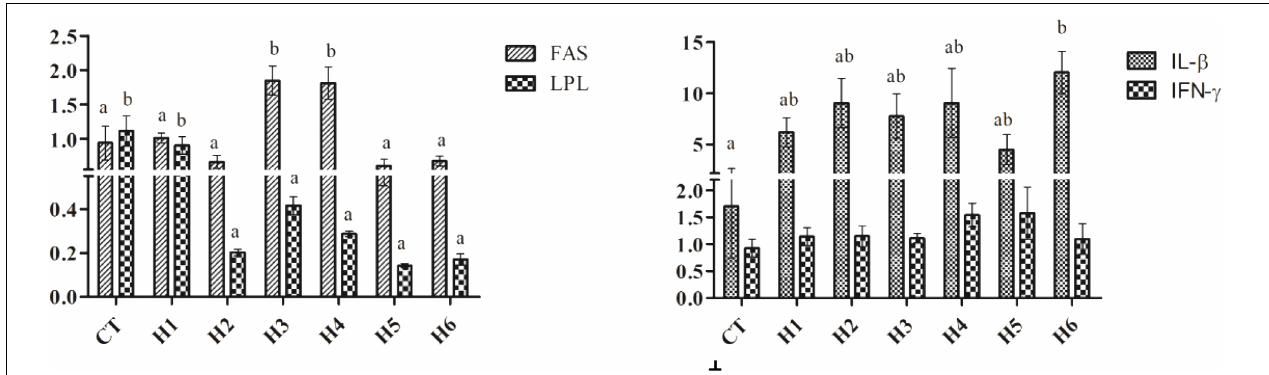
groups ( p > 0.05) but significantly higher than CT and H1 groups ( p < 0.05). There were no significant differences in the level of ALB and GSH-PX activities in the serum in all the groups ( p > 0.05). Serum SOD was significantly higher in H5 and H6 groups in comparison with groups H2 and H3 ( p < 0.05) but similar to the remaining